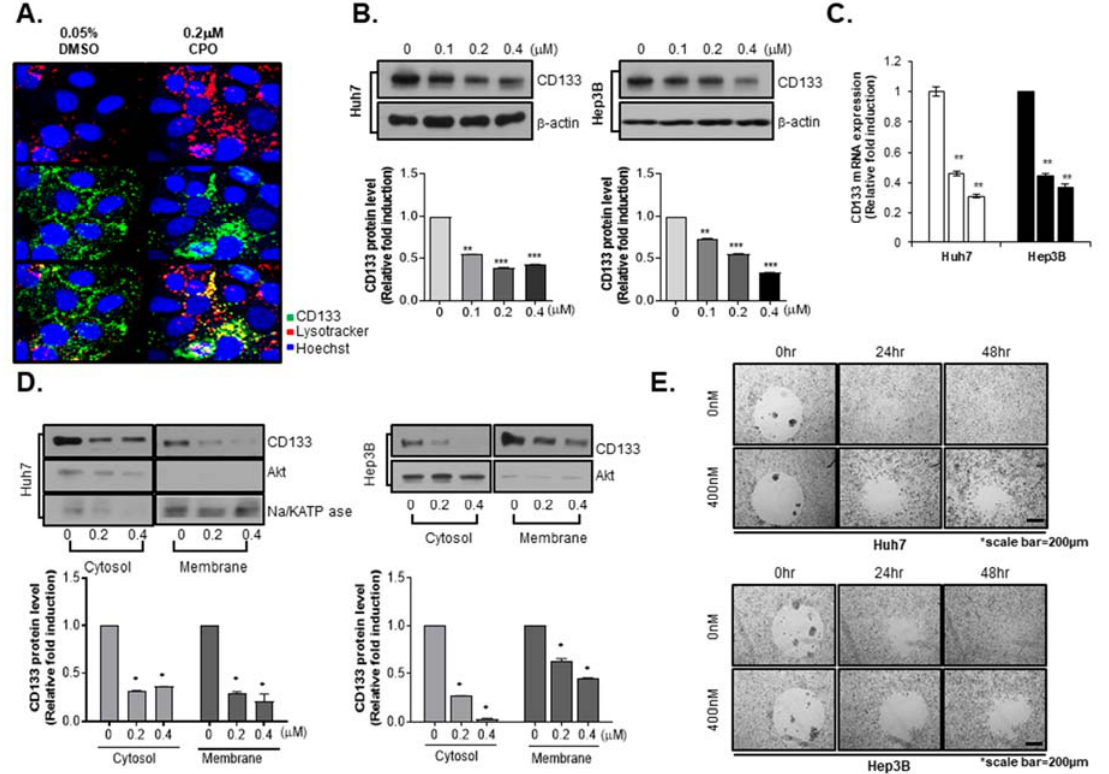
Figure 4. Subcellular localization and degradation of CD133 induced by chromenopyrimidinone (CPO). ( A ) Immunocytochemistry images of CD133 (green), lysosomes (red), and the nucleus (blue) after treating Huh7 cells with or without 200 nM CPO for 48 h. Images were obtained using an HCS system with a 40× objective. ( B ) Expression level of CD133 after treating Huh7 (left panel) and Hep3B (right panel) cells with 100 nM, 200 nM, or 400 nM CPO for 48 h. Expression of proteins was quantified (lower panel). β‐ actin was used as the control (whole blot image, Figure S4). ( C ) Expression level of CD133 mRNA after treating Huh7 and Hep3B cells with 200 nM or 400 nM CPO for 48 h. β‐ actin was used as the control. ( D ) CD133 expression levels in the cytosol and membranes after treating Huh7 (left panel) and Hep3B (right panel) cells with or without 200 nM or 400 nM CPO for 48 h. Expression of CD133 protein was quantified (lower panel). NA + /K + ‐ ATPase was used as a membrane marker, and AKT was used as a cytosol marker. The whole blot image can be found in Figure S5. ( E ) Cell migration capacity after treating Huh7 and Hep3B cells with 400 nM CPO for 24 h or 48 h. Scale bar = 200 μ m. All results shown are from three independent experiments. Data are expressed as mean ± SD; * p < 0.05, ** p < 0.01 and *** p < 0.001 compared to control group.